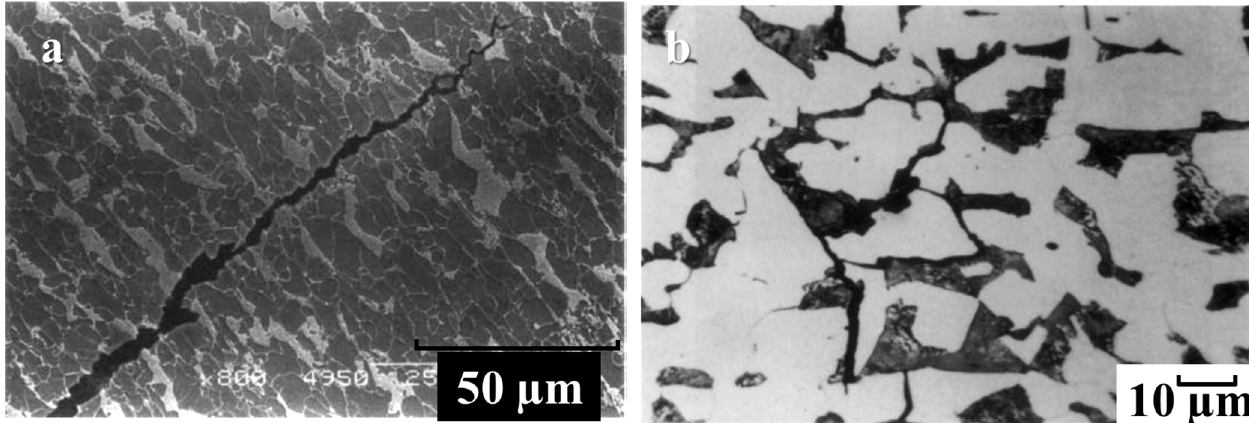
Figure 1. Typical SCC morphology on pipeline carbon steel surfaces; ( a ) trans-granular mode of SCC; ( b ) inter-granular mode of SCC [18]. Reprinted with permission from [18], 2011, John Wiley and Sons.